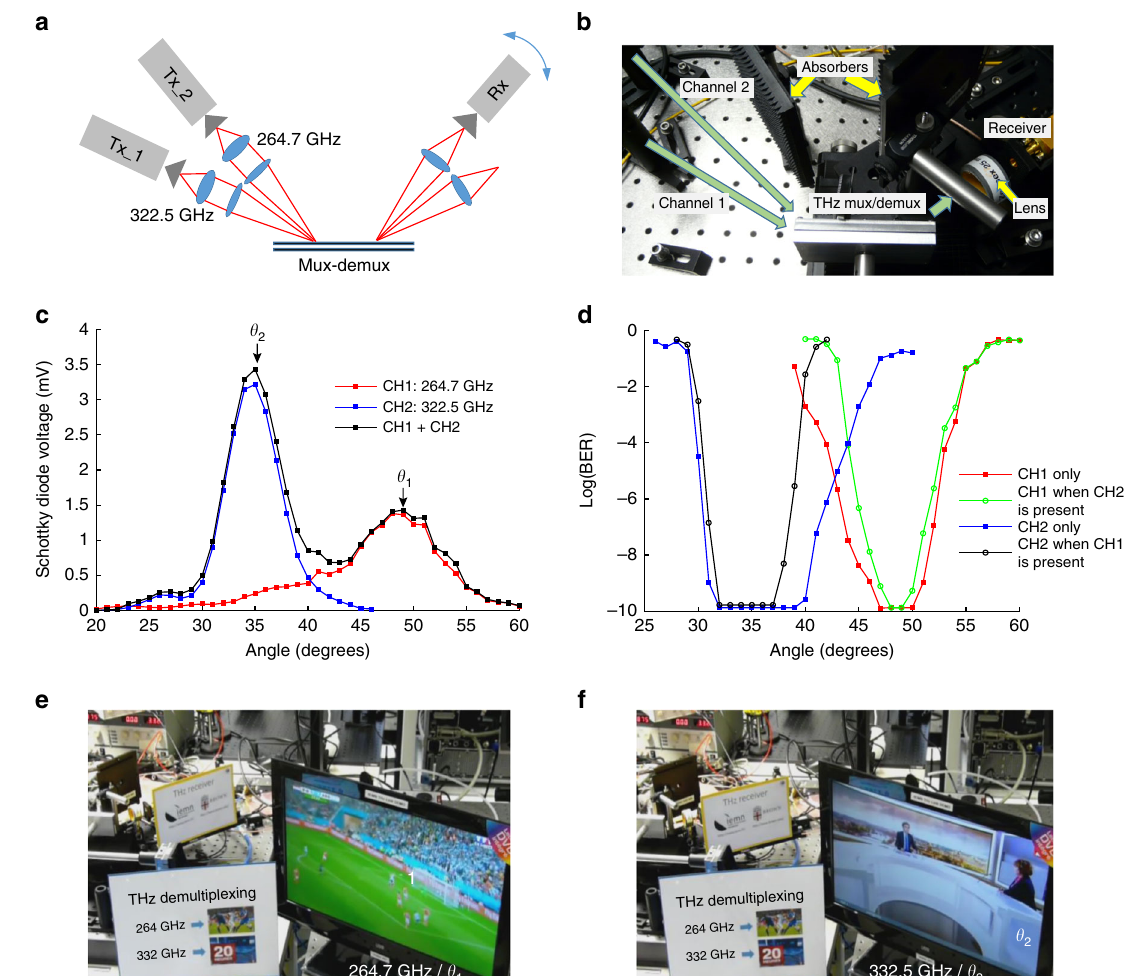
Fig. 3 Schematic diagram and multiplexing/demultiplexing of two THz channels. a Schematic showing the measurement setup, with two different transmitters at 264.7 GHz and 332.5 GHz at fi xed angular positions, and with the receiver mounted on a pivoting rail to vary the measurement angle. Power pattern and BER performance for both real-time links at 264.7 GHz and 332.5 GHz are measured after mux-demux with data rate at 1.5 Gb/s. b View of the mux-demux in the experimental setup. c Power pattern measured when channel 1 (264.7 GHz) is on while channel 2 (322.5 GHz) is off ( red curve ), channel 2 is on, whereas channel 1 is off ( blue curve ), and both channels are on ( black curve ). d BER performance for channel 1 only ( red ), channel 2 only ( blue ), channel 1 when channel 2 is on ( light green ) and channel 2 when channel 1 is on ( dark green ). Error-free operation can be achieved in both channels even with both signals on. ( e , f ) Two real-time videos (HD-TV broadcast) transmitted by the two THz links at 264 GHz and 332.5 GHz, each with a data rate of 1.5 Gb/s. The video signals are taken from two different TV broadcast channels and connected to the transmitters. In the monitor connected to the detector, the channel switches when the angular position of the receiver changes. This THz mux/demux can be observed in operation in the